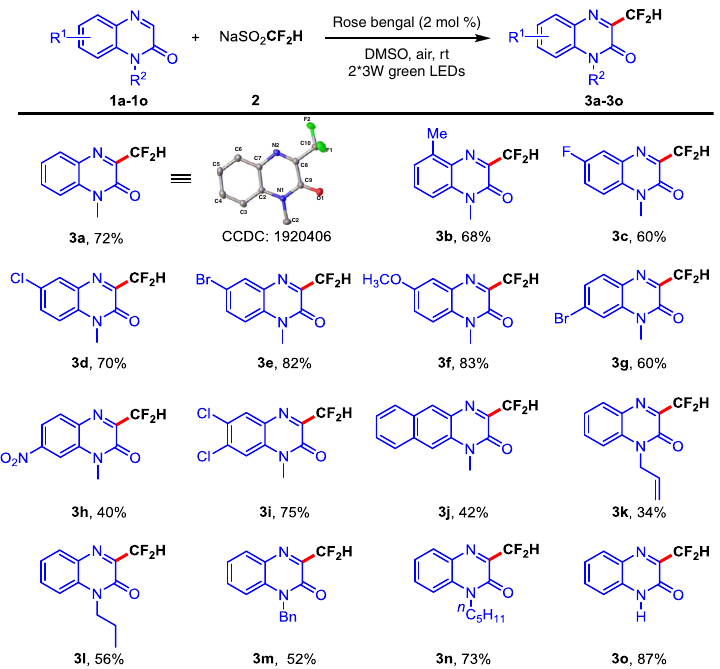
Fig. 2 Substrate scope of quinoxalin-2(1 H )-ones. Reaction conditions: 1 (0.2 mmol), CF 2 HSO 2 Na 2 (0.4 mmol), rose bengal (2 mol%) in 1 mL DMSO under two 3 W green LEDs irradiation at room temperature. Isolated yields based on 1 .